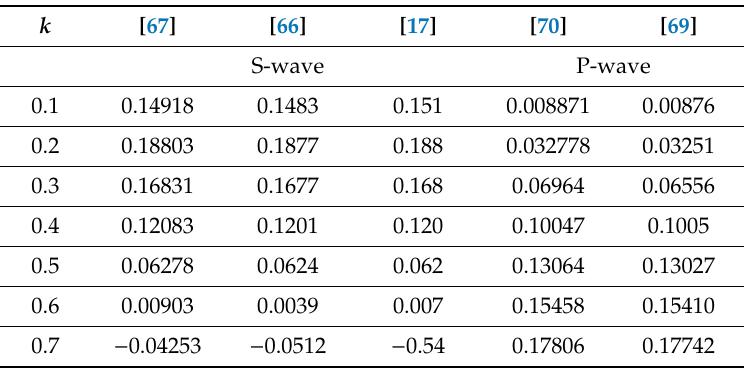
Table 14. Comparison of S-wave and P-wave phase shifts